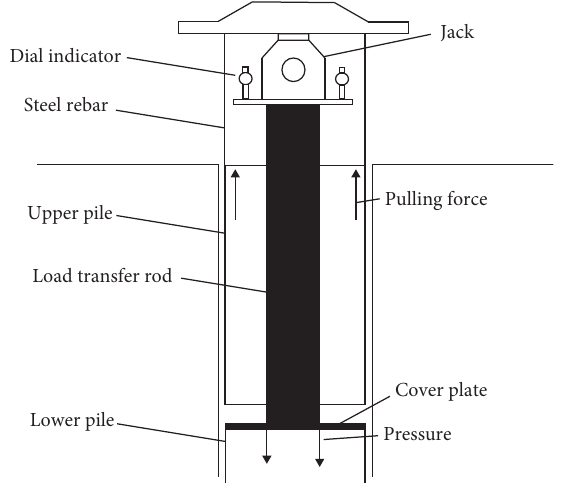
Figure 1: Schematic diagram of self-anchored test